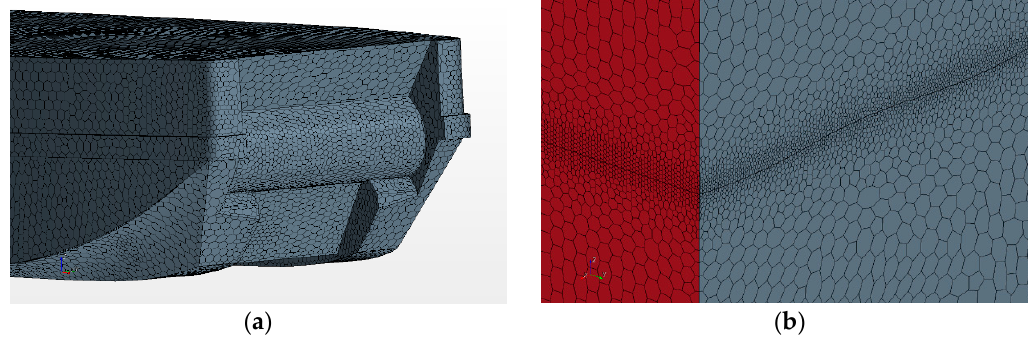
Figure 18. Mesh generation on ( a ) hull body and ( b ) free surface.